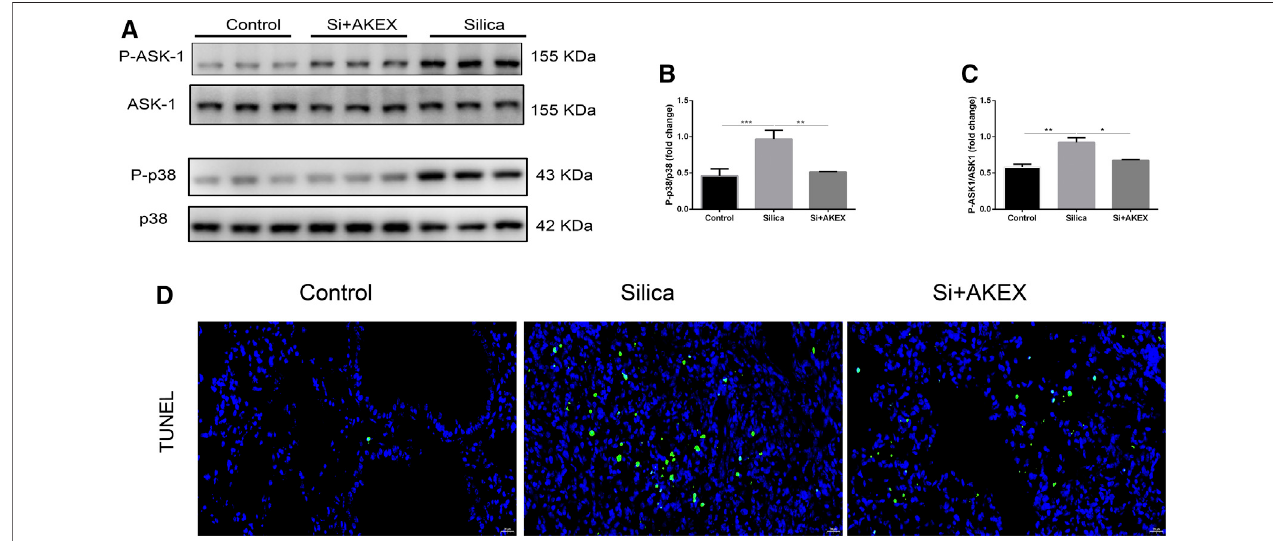
FIGURE 7 | AKEX0011 inhibited in fl ammation and fi brosis by blocking the ASK-p38 MAPK signaling pathways and apoptosis. There were three experimental groups:thePBScontrolgroup(abbreviatedas “ Control ” inthegraphs),silica+vehiclegroup(abbreviatedas “ Silica ” ),andsilica+AKEX0011group(abbreviatedas “ Si+ AKEX ” ) in the experiments of Figure 7 and Figure 8 . (A) WB of P-ASK1, ASK1, P-p38, and p38. (B-C) Quanti fi cation of band densities from WB images in (A). (D) TUNEL staining. All data were presented as mean ± SEM; * p < 0.05, ** p < 0.01, and *** p <